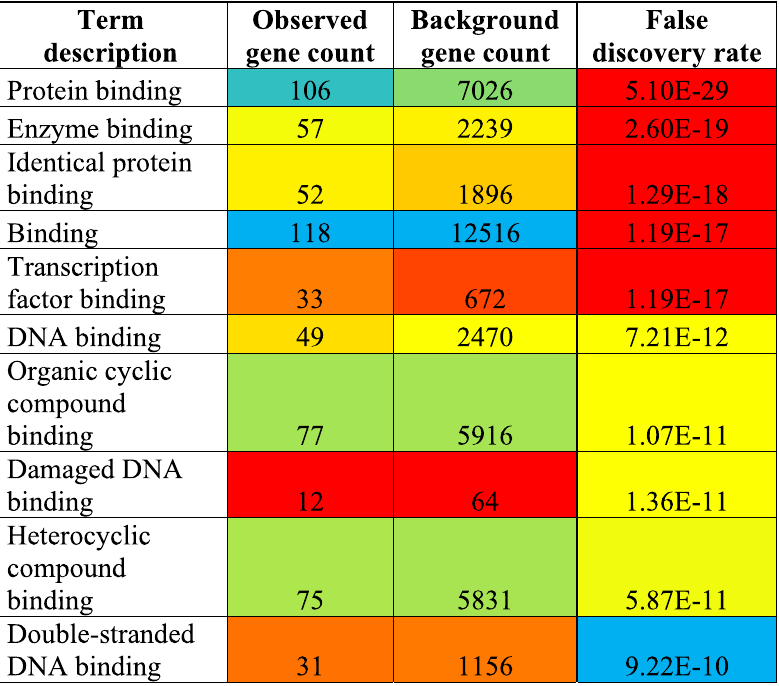
Table 3 Top 10 molecular functions involved in